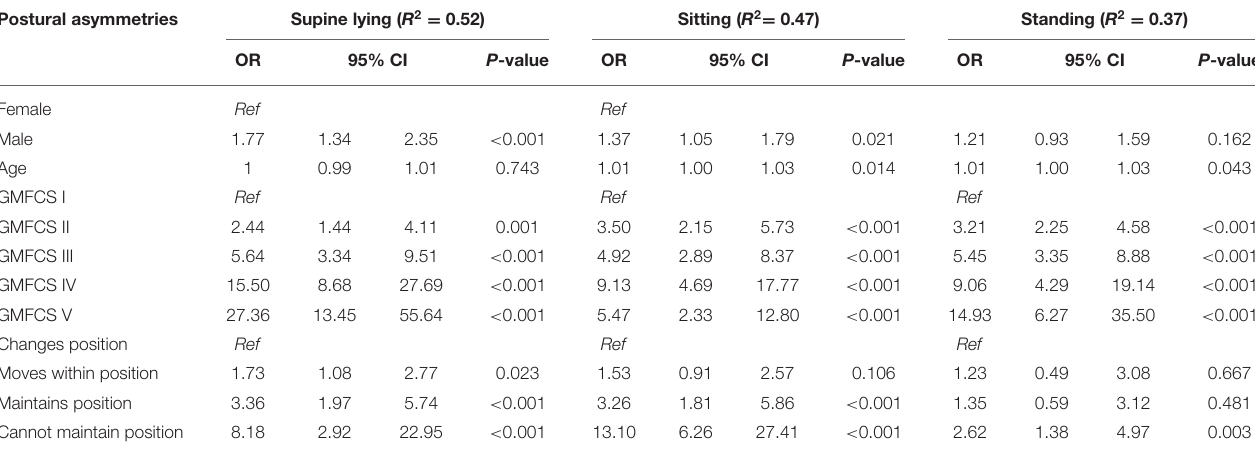
TABLE 4 | Odds ratios (OR) with 95% confidence intervals (CI) and R square ( R 2 ) estimated for moderate to severe postural asymmetries in lying, sitting and standing positions. Postural asymmetries Supine lying ( R 2 = 0.52) Sitting ( R 2 =